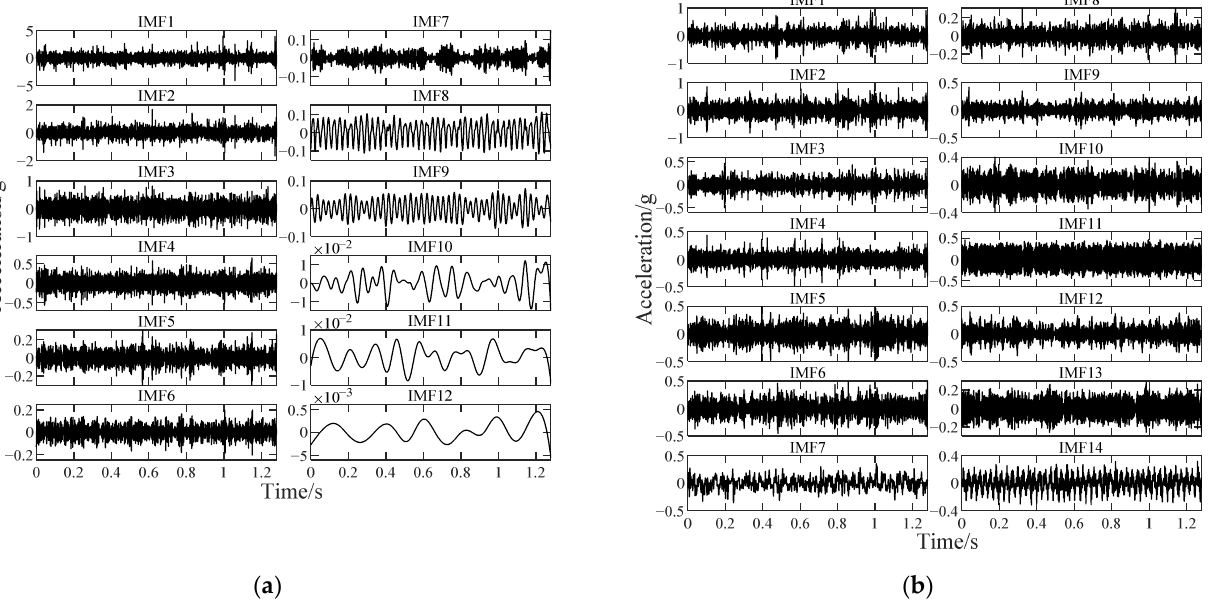
= , α = ). v 14 k v 63.1